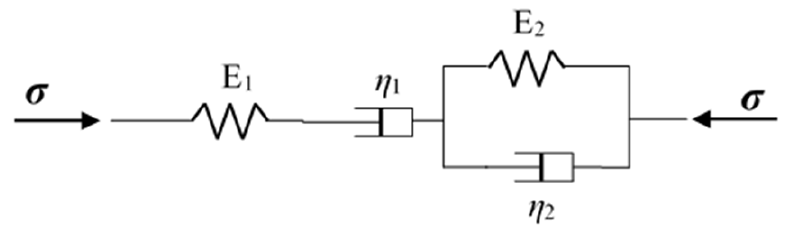
Figure 1. Burgers